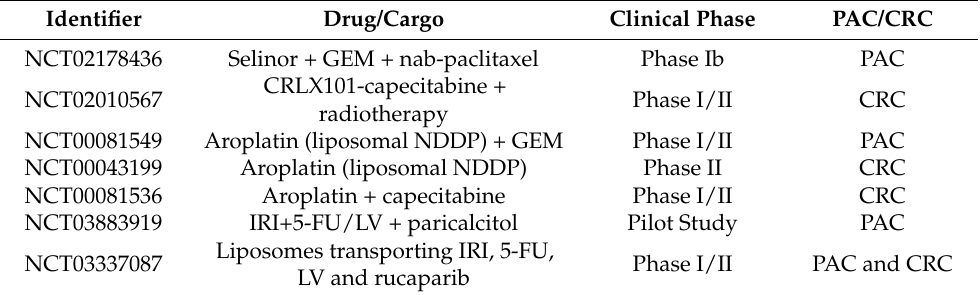
Table 3. Clinical trials using NPs designed against CRC and PAC to overcome multidrug